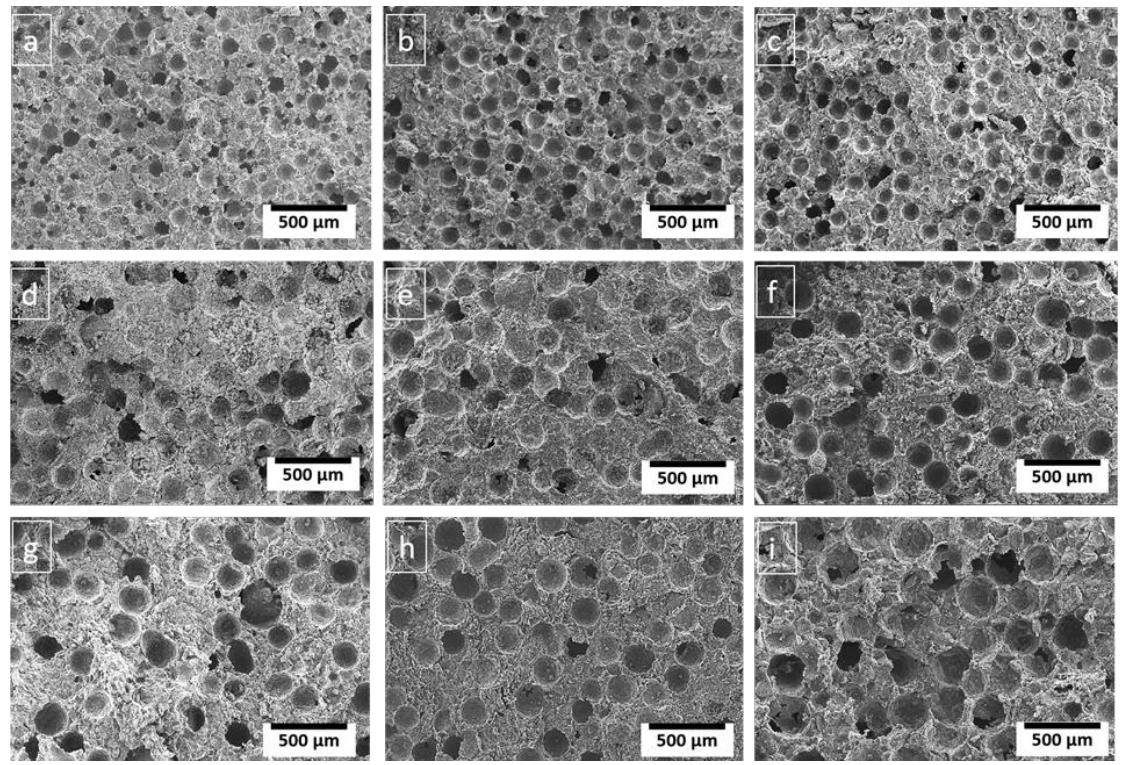
Figure 5. SEM micrography of porous Al composites at three particle size of PMMA viz 75 μm , 125 μm and 150 μm with varying PMMA particle content of ( a , d , g ) 20 wt.%, ( b , e , h ) 25 wt.%, and ( c , f , i ) 30 wt.%